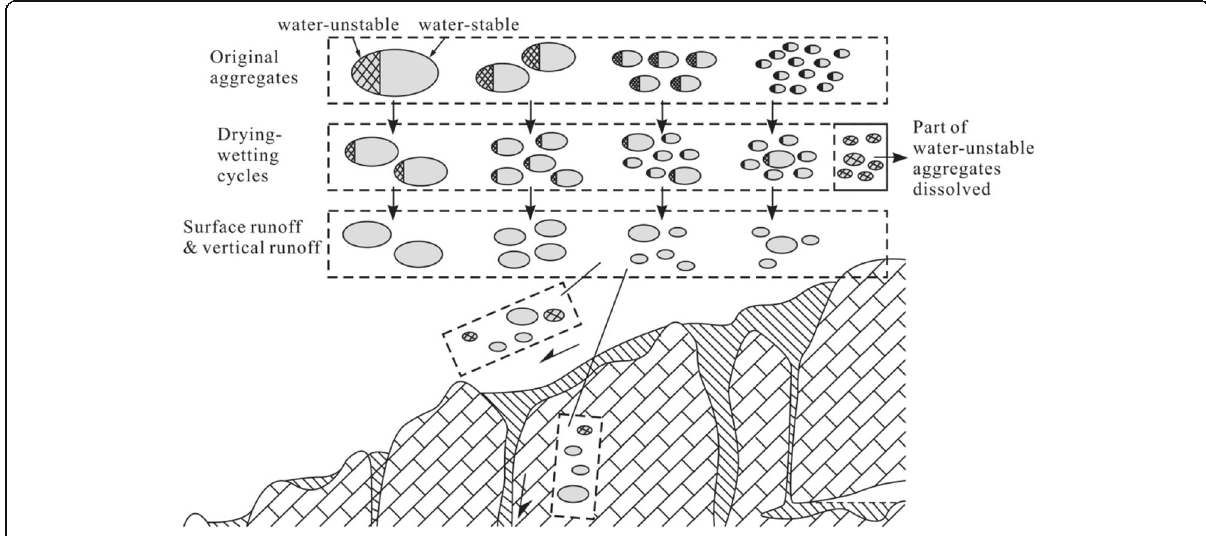
Fig. 9 Breakdown and leakage model for the aggregates in karst areas